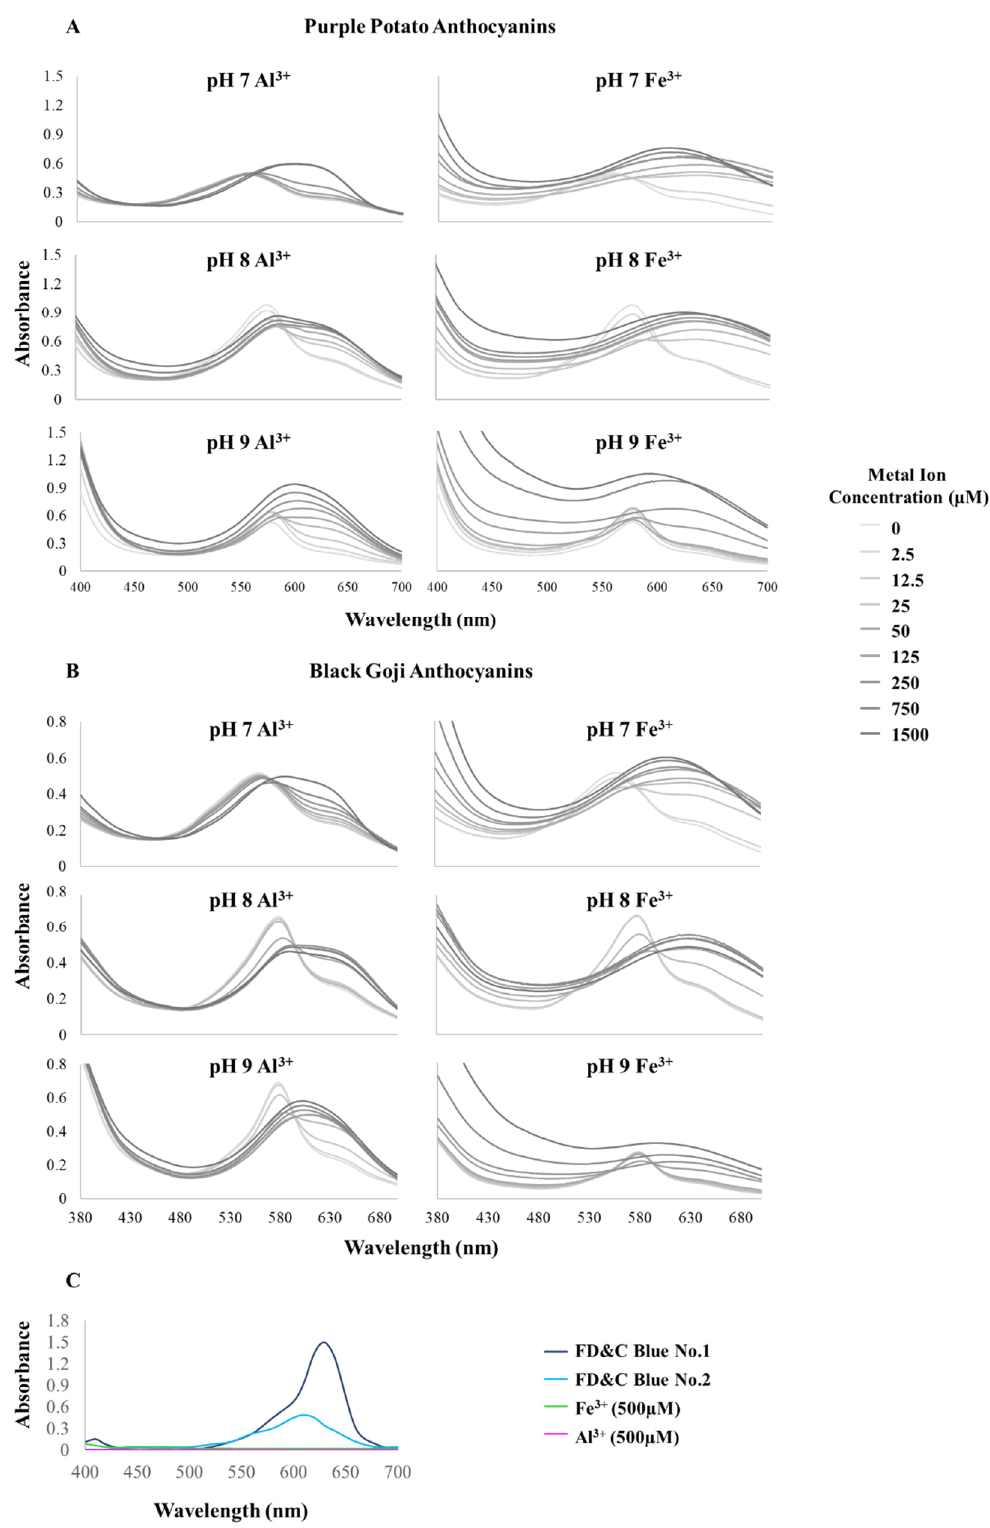
Figure 2. Spectral characteristics of purple potato ( A ) and black goji ( B ) anthocyanin metal chelates at neutral and alkaline pH. The control groups including FD&C Blue colorants and metal ions (500 µM) were shown in ( C ). Data were collected 1 hr after the anthocyanins were mixed with metal ions and pH adjustment with the buffers. The spectra at acidic pHs are not presented due to no impact of metal addition.